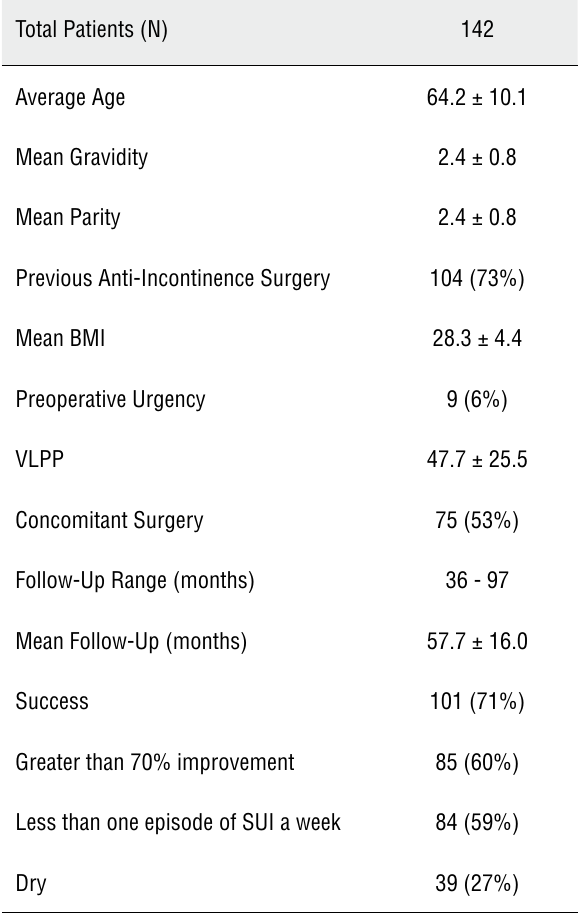
Table 1 - Overall Patient Demographics and Surgical